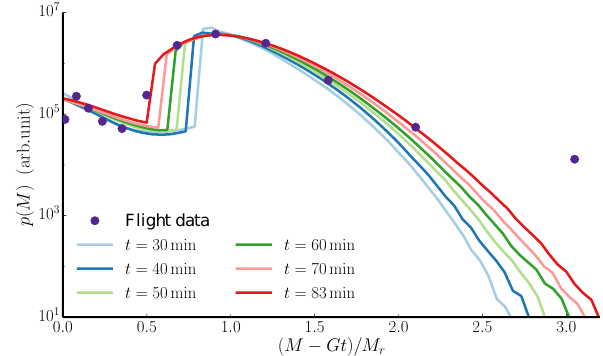
Figure 5. Evolution of the cloud-top DSD. The droplets in the sim- ulations grow only by condensation due to radiative cooling. The points correspond to measurements from the VERDI